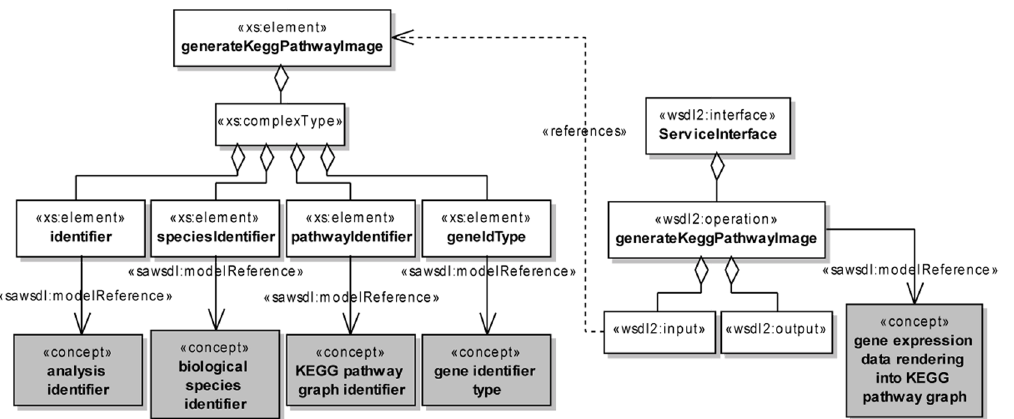
Fig 6. UML class diagram representing the semantic annotation of the WSDL operation generateKeggPathwayImage. A named rectangle represents a UML class. A white class represents a WSDL element, while a gray class represents a concept from the GEXPASO ontology. A directed solid line (UML association) stereotyped as < < sawsdl:modelReference > > represents the use of the modelReference extension attribute to annotate a WSDL element with a GEXPASO concept. A directed dashed line (UML dependency) stereotyped as < < references > > indicates that a WSDL element references another one. Finally, a solid line with an hollow diamond (UML aggregation) is used to indicate a WSDL element contained as part of another one.